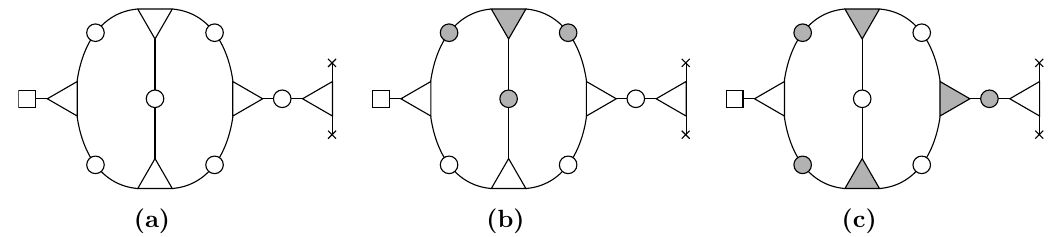
Figure 5. A genus 2, single-puncture example of a possible generalization of the diagrams in (cid:12)gure 2. In our notation, these all have n tot = 1, n dif = n 0 + n 0 = 3 ; h 2 = 2. All three diagrams have the same IR central 1 2